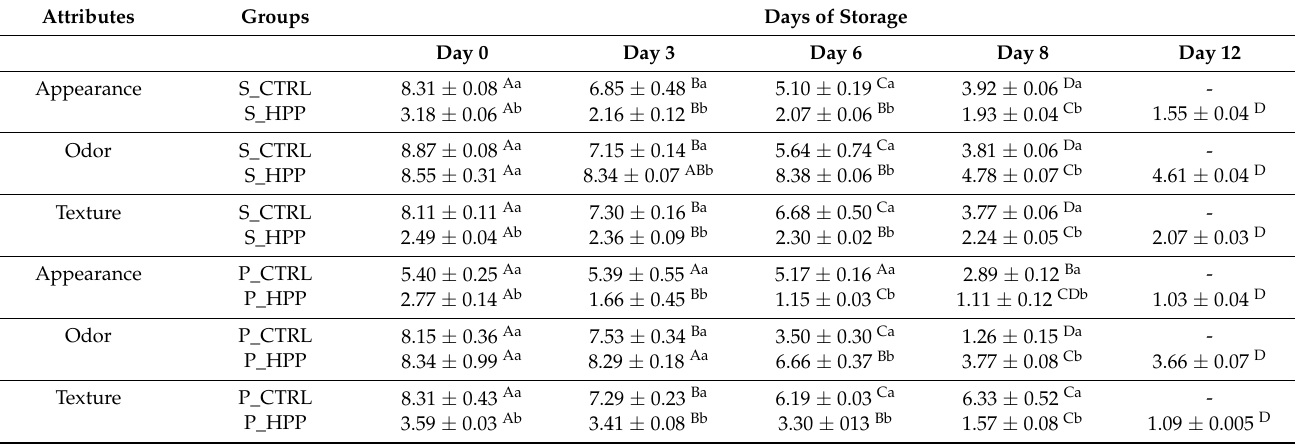
Different uppercase letters in the same line indicate significant differences within storage days for each parameter ( p ≤ 0.05). Different lowercase letters in the same column indicate significant differences between groups for each parameter ( p ≤